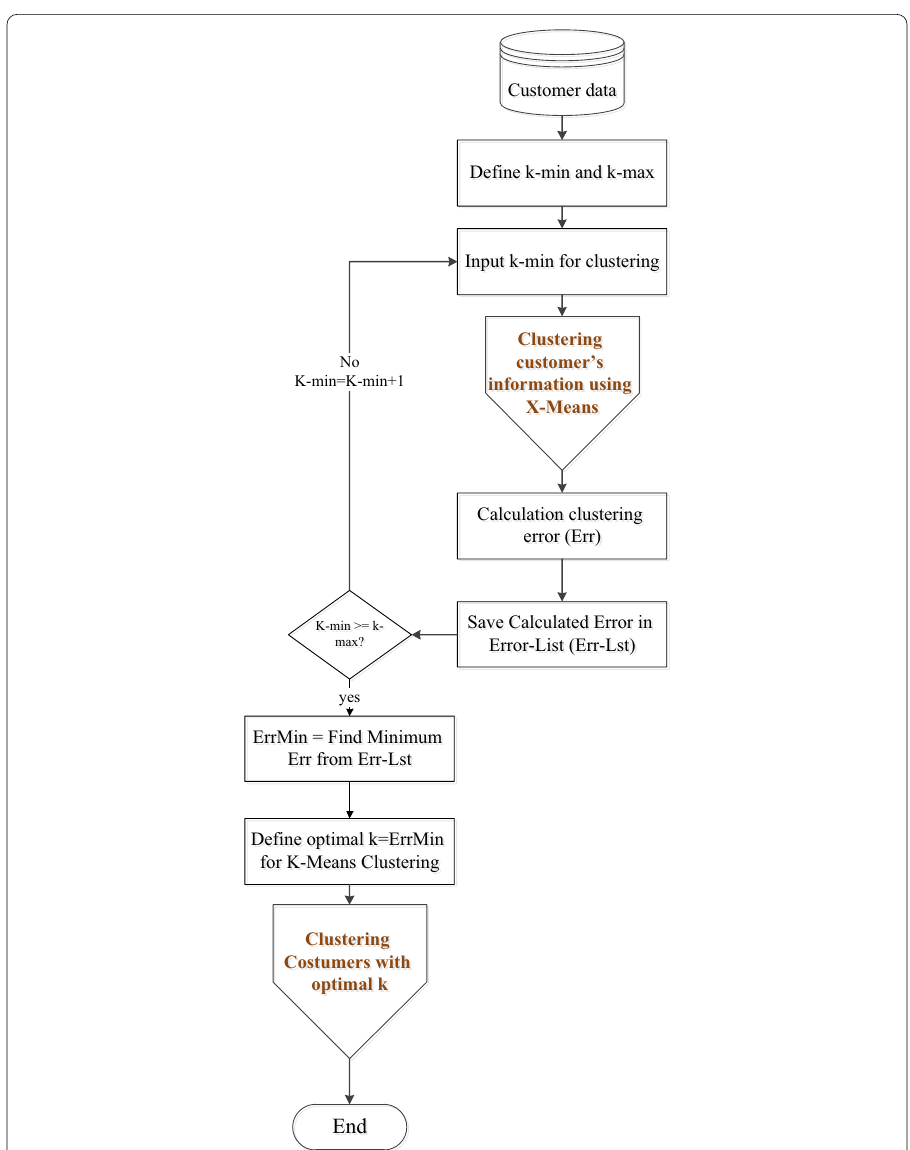
Fig. 1 Structure of XK-means clustering algorithm for clustering customer’s